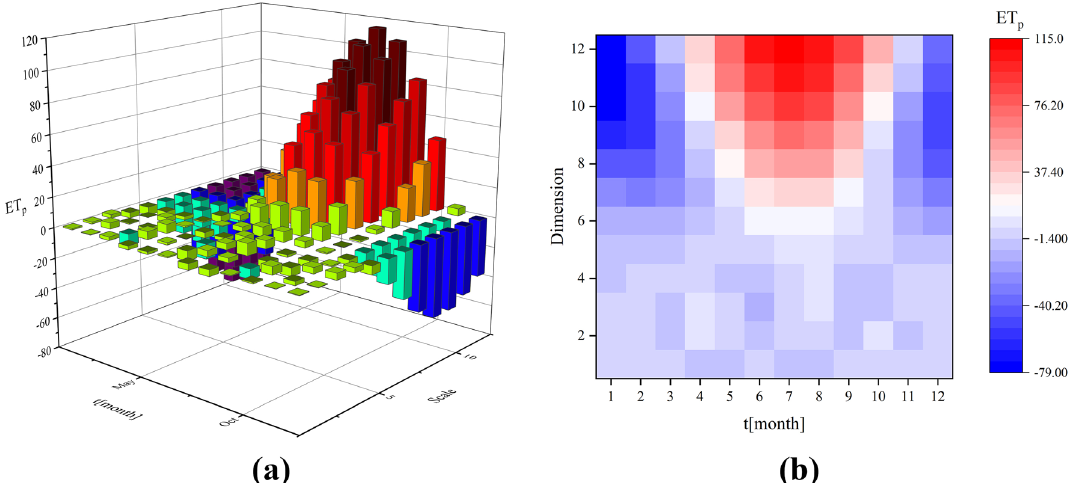
Figure 3. Wavelet transform 3D Bars and real part time–frequency distribution Haetmap for Hancang River Basin. (The figure was generated by Origin 2019b software, https:// www. origi nlab.